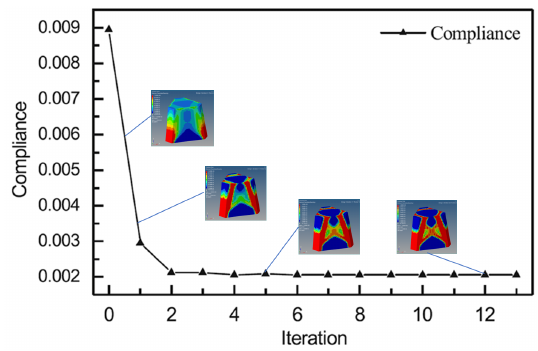
Figure 4. Topological convergence process. Table 2. Displacement values of the